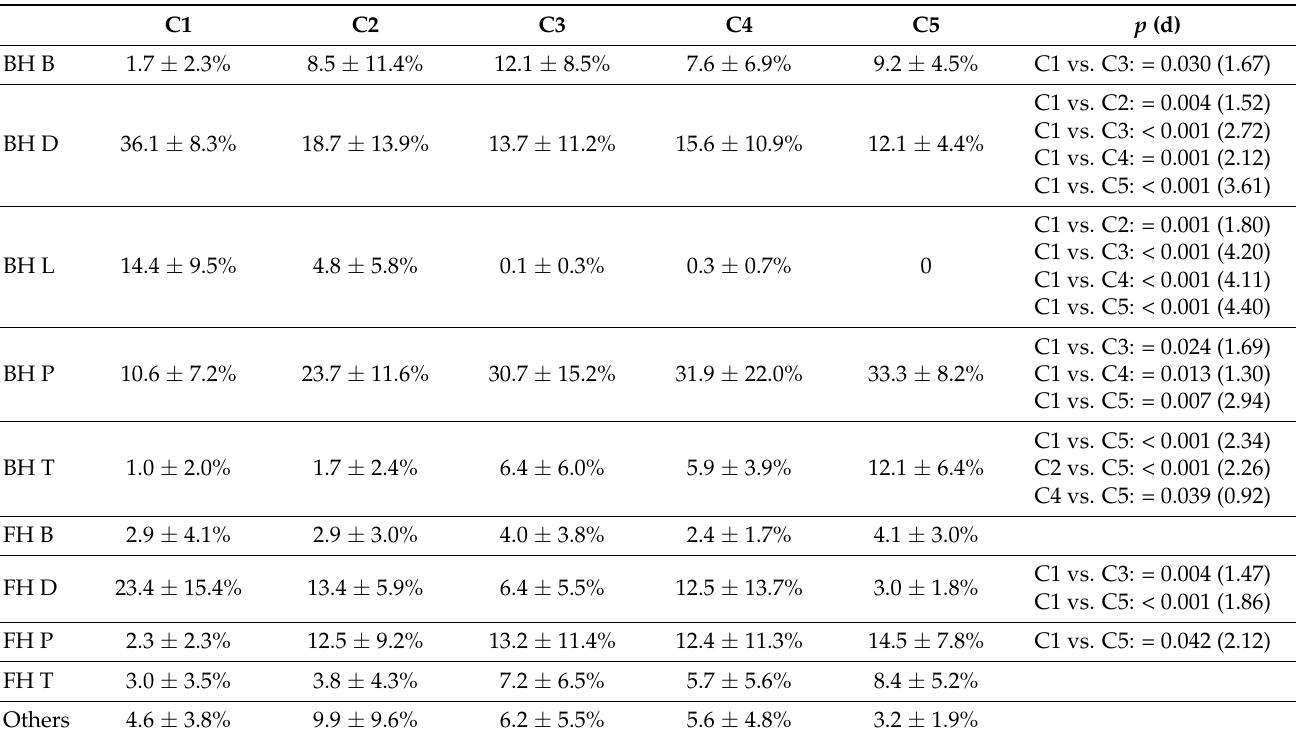
Table 5. Distribution of strokes type (serve excluded) in backhand and forehand executions for each class (mean ±